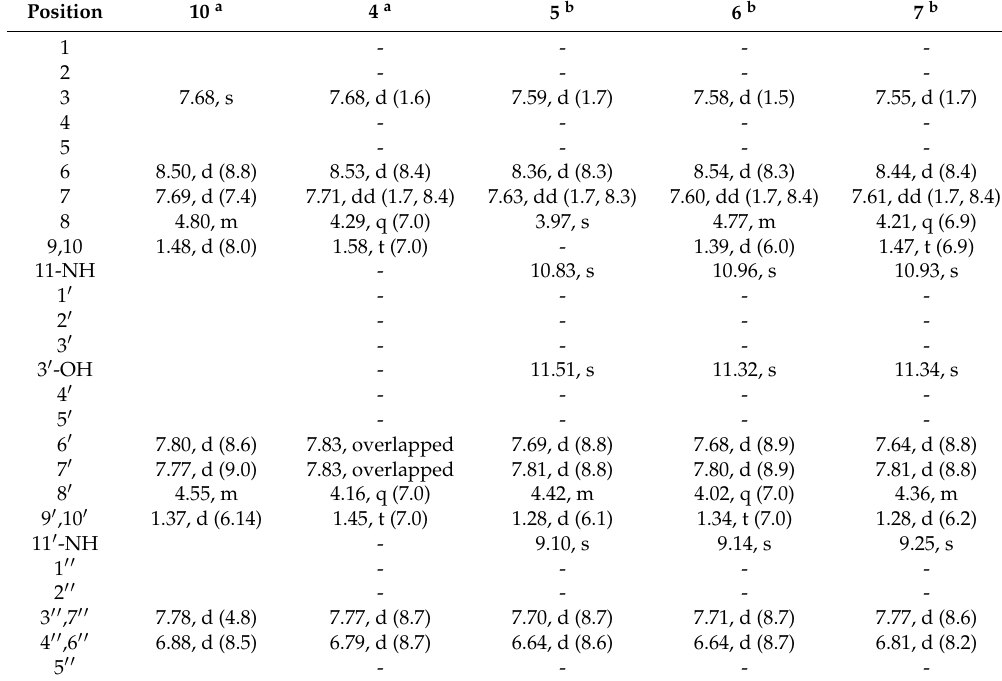
Table 4. 1 H NMR data for 4 – 7 .